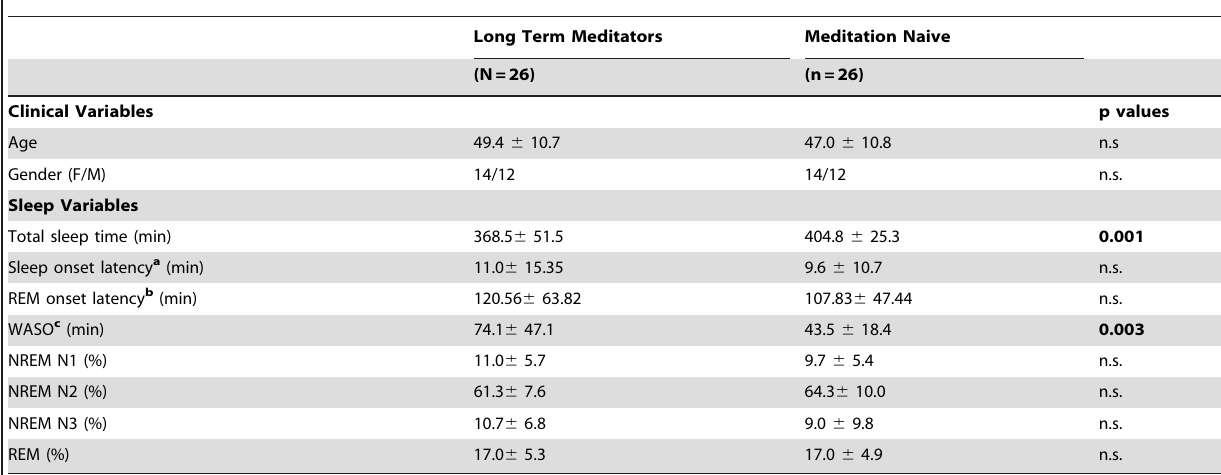
Table 2. Clinical and sleep variables of subject groups.